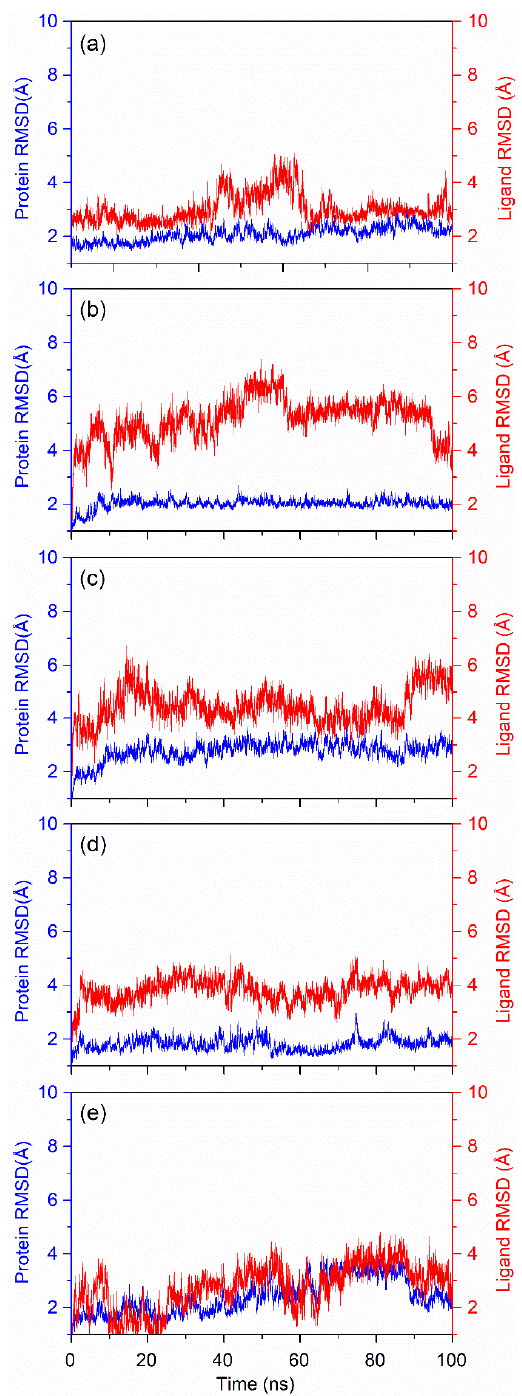
Figure 6. Root-mean-square deviation (RMSD) of proteins and ligands for the docked poses obtained from 100 ns MD simulations for ( a ) desmopressin, ( b ) rutin, ( c ) lypressin, ( d ) lanreotide, and ( e ) 68T. C α atoms of protein were used for RMSD calculations (blue); ligand RMSD (red) was calculated for heavy atoms by fitting the protein–ligand